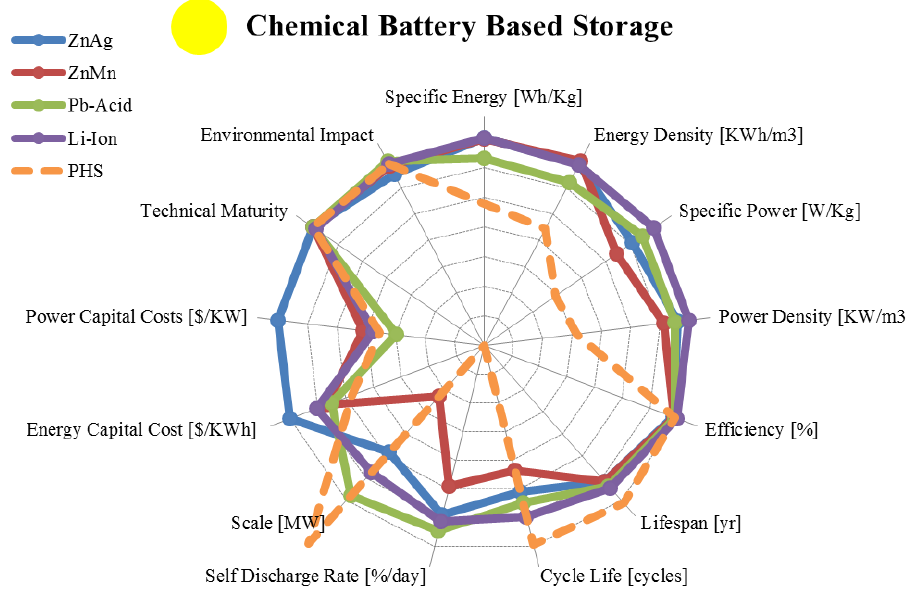
Figure 5. Comparing chemical energy storage in typically batteries using normalized and logarithmically plotted average data from Table